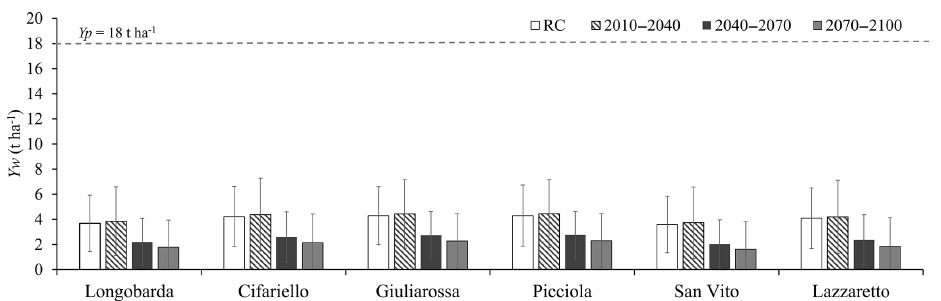
Figure 4. The projected effects of simulated soil compaction on Yw for all the soil series assuming the presence of a compacted plow layer at 30cm depth. Other terms are explained in Fig. 2.